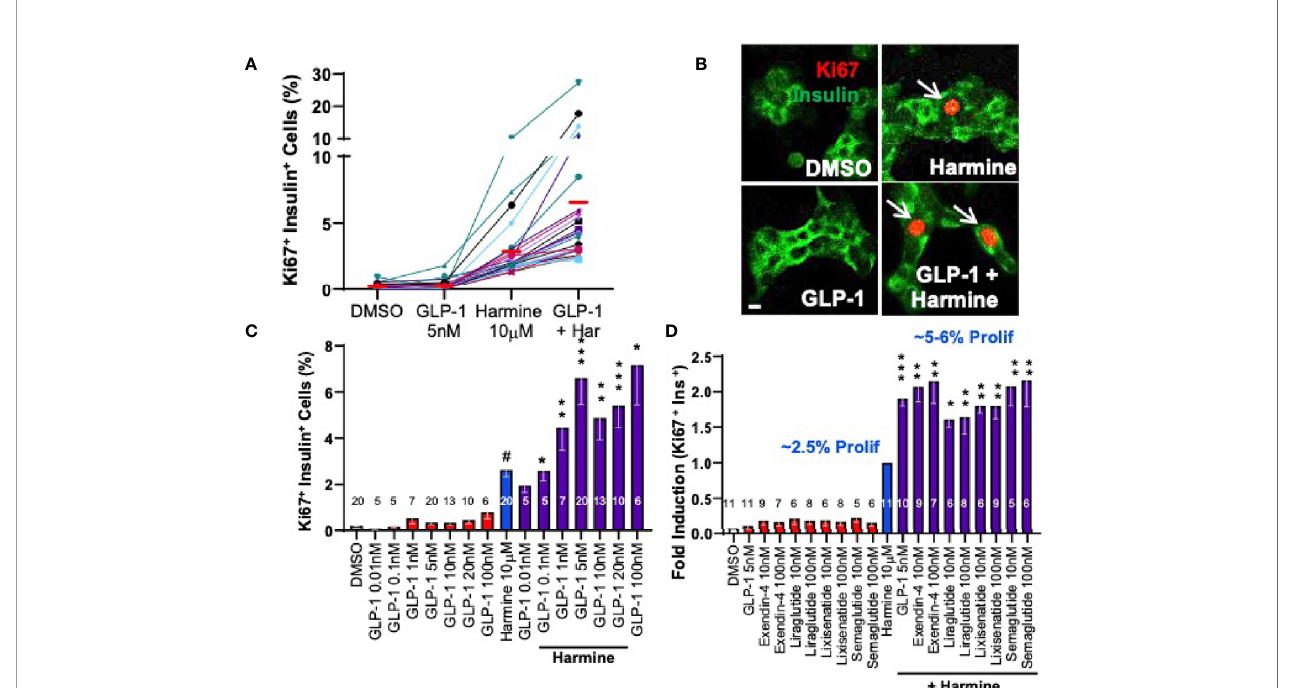
FIGURE 5 | Adult Human Beta Cell Proliferation in Response to Combined Treatment with Harmine and GLP1R Agonists. (A) Proliferation (Ki67 labeling index) in human islets exposed for 72 hours to vehicle (0.1% DMSO), GLP1, harmine or GLP1 plus harmine. Each colored line represents one of 20 different human islet preparations assayed for all four treatments. The red bars represent the mean for each dose. (B) An example of Ki67 immunolabeling (red) in dispersed human beta cells (green). (C) Dose-response curves for Ki67 labeling in human beta cells in response to multiple doses of GLP1 alone, or the maximally effective dose of harmine (10 µM) alone, or the harmine-GLP1 combination. (D) Comparison of clinically available GLP1 receptor agonists alone or in combination with harmine. Note that for harmine, Ki67 labeling is 2.4%, but is normalized to 1.0-fold, so that the 2-fold increase in proliferation for the combinations re fl ects mean Ki67 labeling indices of 5- 6%. Note also that none of the GLP1R agonists in clinical use induce human beta cell proliferation. All panels reproduced with permission from (29), which contains complete details. *p < 0.05; **p < 0.01, ***p <